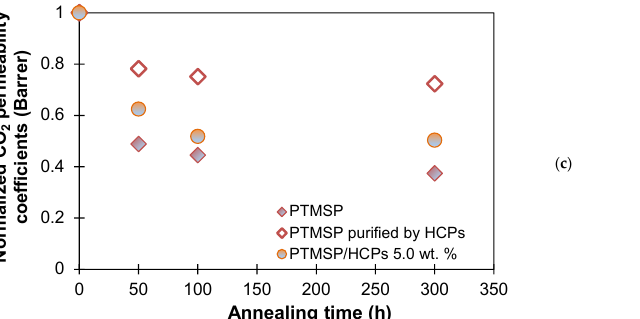
Figure 7. N 2 ( a ), O 2 ( b ), and CO 2 ( c ) permeability coefficients for PTMSP membrane (painted diamond), PTMSP purified by HCPS (unpainted diamond), and PTMSP/HCPS 5.0 wt % (painted circle) against annealing time at 100 °C.